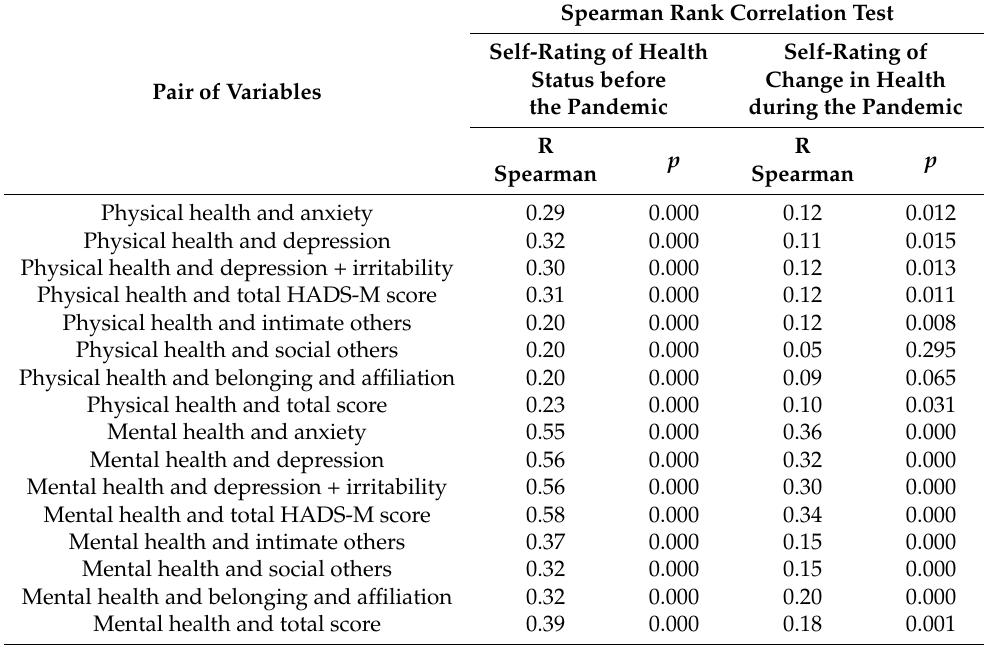
Table 5. Self-rating of health status before the pandemic and assessment of health changes during the pandemic regarding R-UCLA and HADS-M. Spearman Rank Correlation Test Pair of Variables